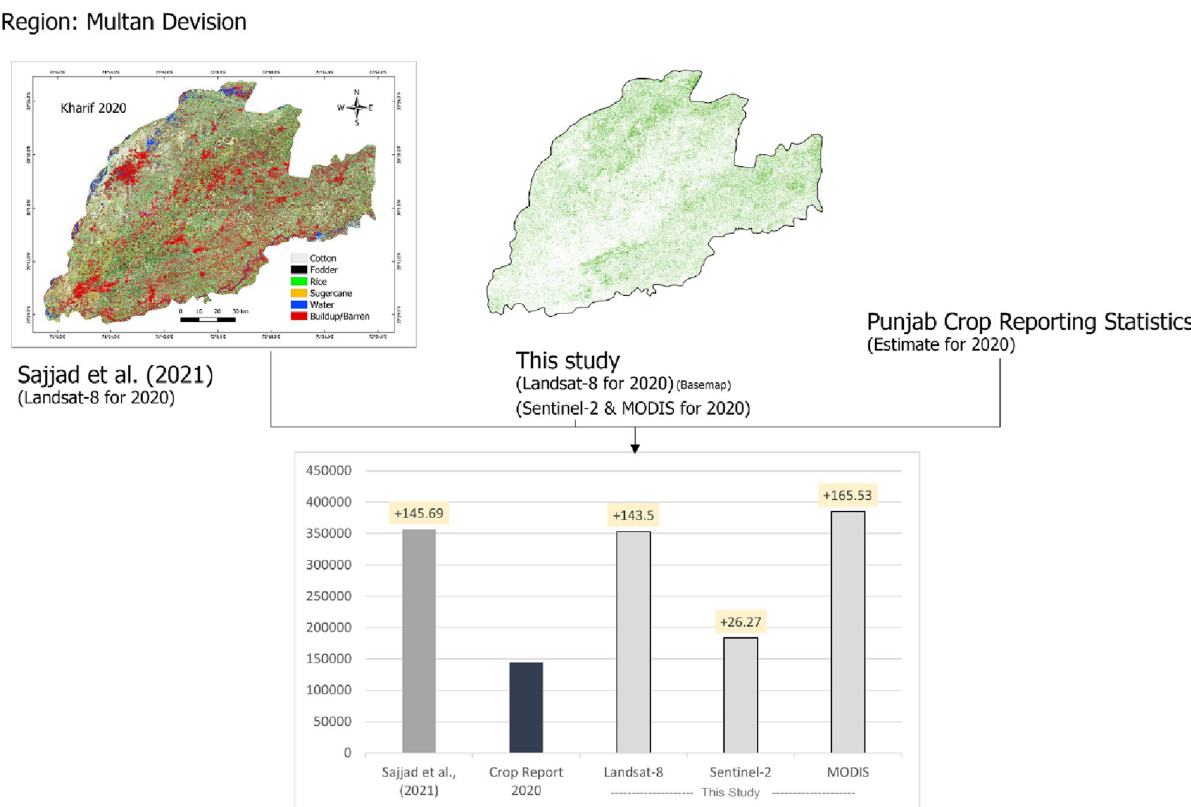
Figure 11. Comparing our rice estimated area using three instruments with previously published study 70 and crop statistics report for 2020. Note: in the Figure area is compared for Multan division, and call-outs in bar plots shows the percentage increase or decrease in area compared to crop statistics report. The Figure is designed in Photoshop V23.3 software provided by Adobe (https:// www. adobe. com/ produ cts/ photo